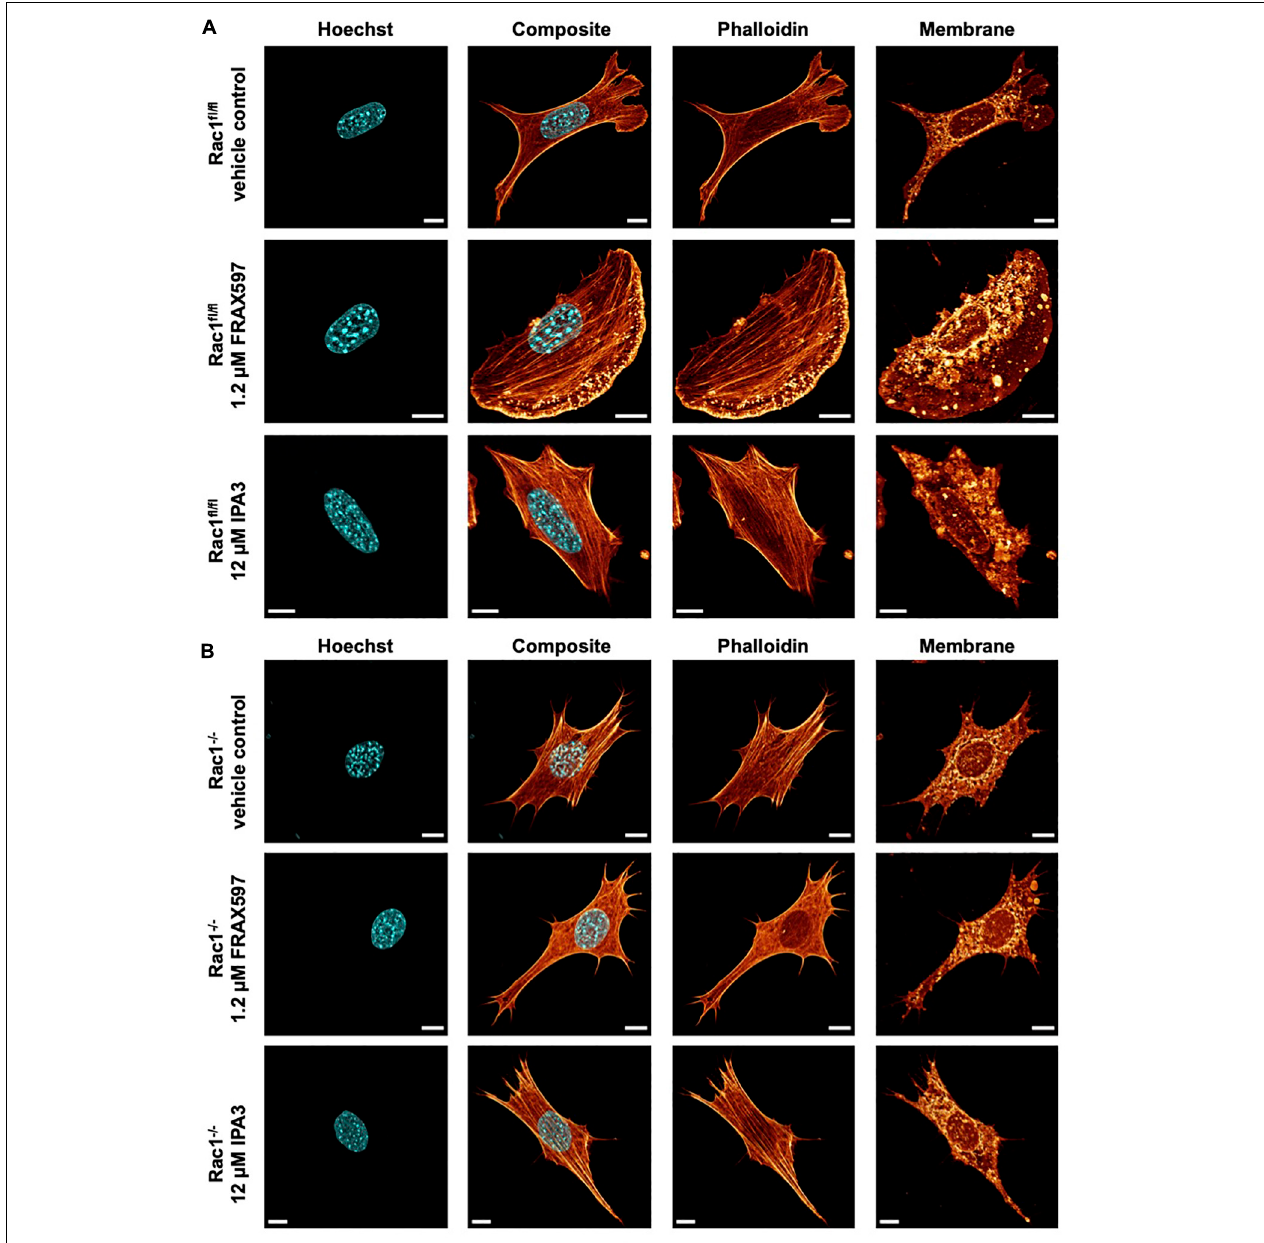
FIGURE 3 | Inhibition of group I PAKs and PAK1 by FRAX597 and IPA3 alters the morphology and the actin cytoskeleton of Rac1 fl / fl and Rac1 − / − cells using a confocal laser scanning microscopy. Cells were cultured on planar substrates coated with 10 µ g/ml laminin and treated for 2 h with 1.2 µ M FRAX597 or 12 µ M IPA3. After fixation, the cells were stained with Alexa Fluor 546 phalloidin, Hoechst and DID. (A) Nuclear shape, composite of nuclear shape and action cytoskeleton, actin cytoskeleton and membrane shape of a representative Rac1 fl / fl cell in absence (top row) and presence of FRAX597 (intermediate row) or IPA3 (bottom row) is presented. (B) Nuclear shape, composite of nuclear shape and action cytoskeleton, actin cytoskeleton and membrane shape of a representative Rac1 − / − cell in absence (top row) and presence of FRAX597 (intermediate row) or IPA3 (bottom row) is presented. All scale bars are 10 µ